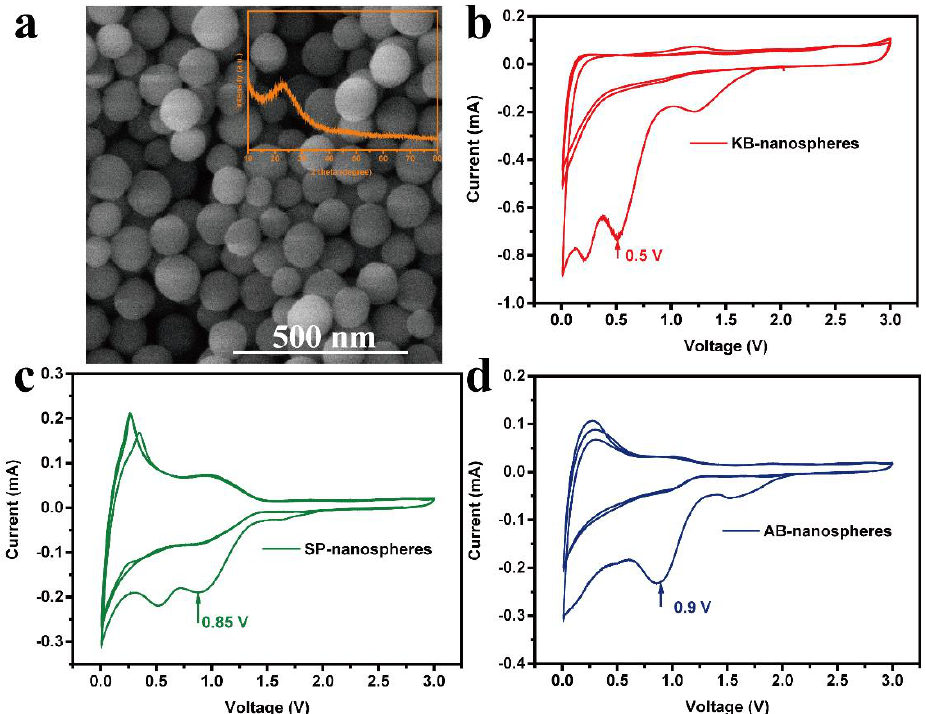
Figure 9. The SEM image and XRD pattern (the inset) ( a ) of silica nanospheres, CV curves of the first three cycles of the silica nanospheres when using KB ( b ), SP ( c ), and AB ( d ) as conductive agents, respectively.